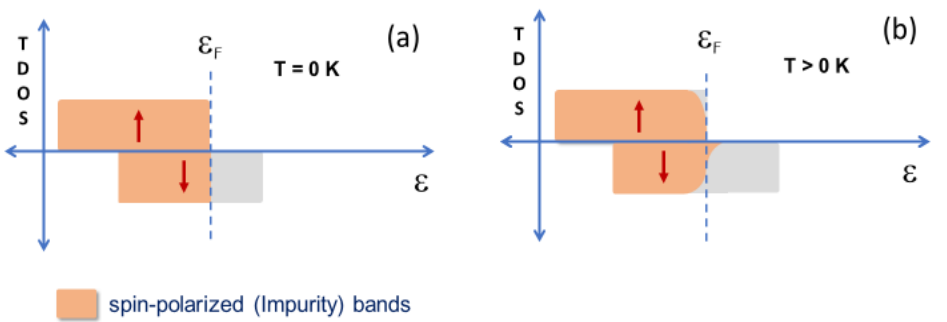
Figure 9. Total density of states: scheme proposed for the doped semiconductor at T = 0 K ( a ) and T > 0 K ( b ).